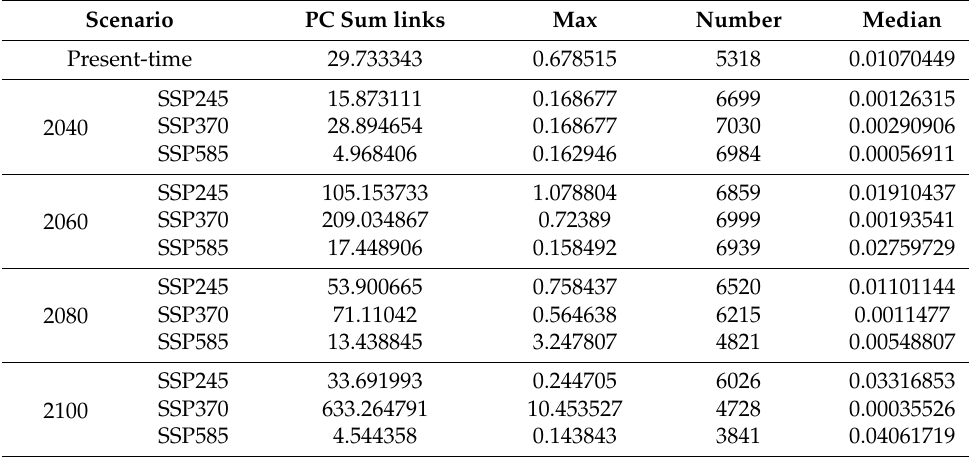
Table 4. Variation in the importance of connectors with the 60–100%